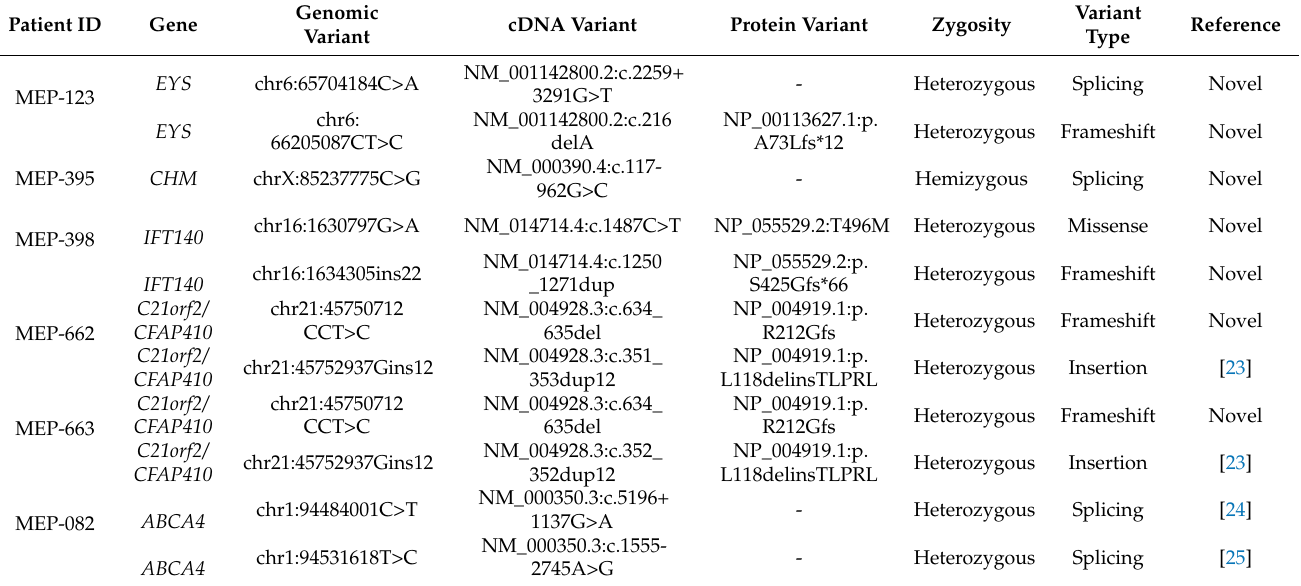
Table 1. Identified variants in IRD